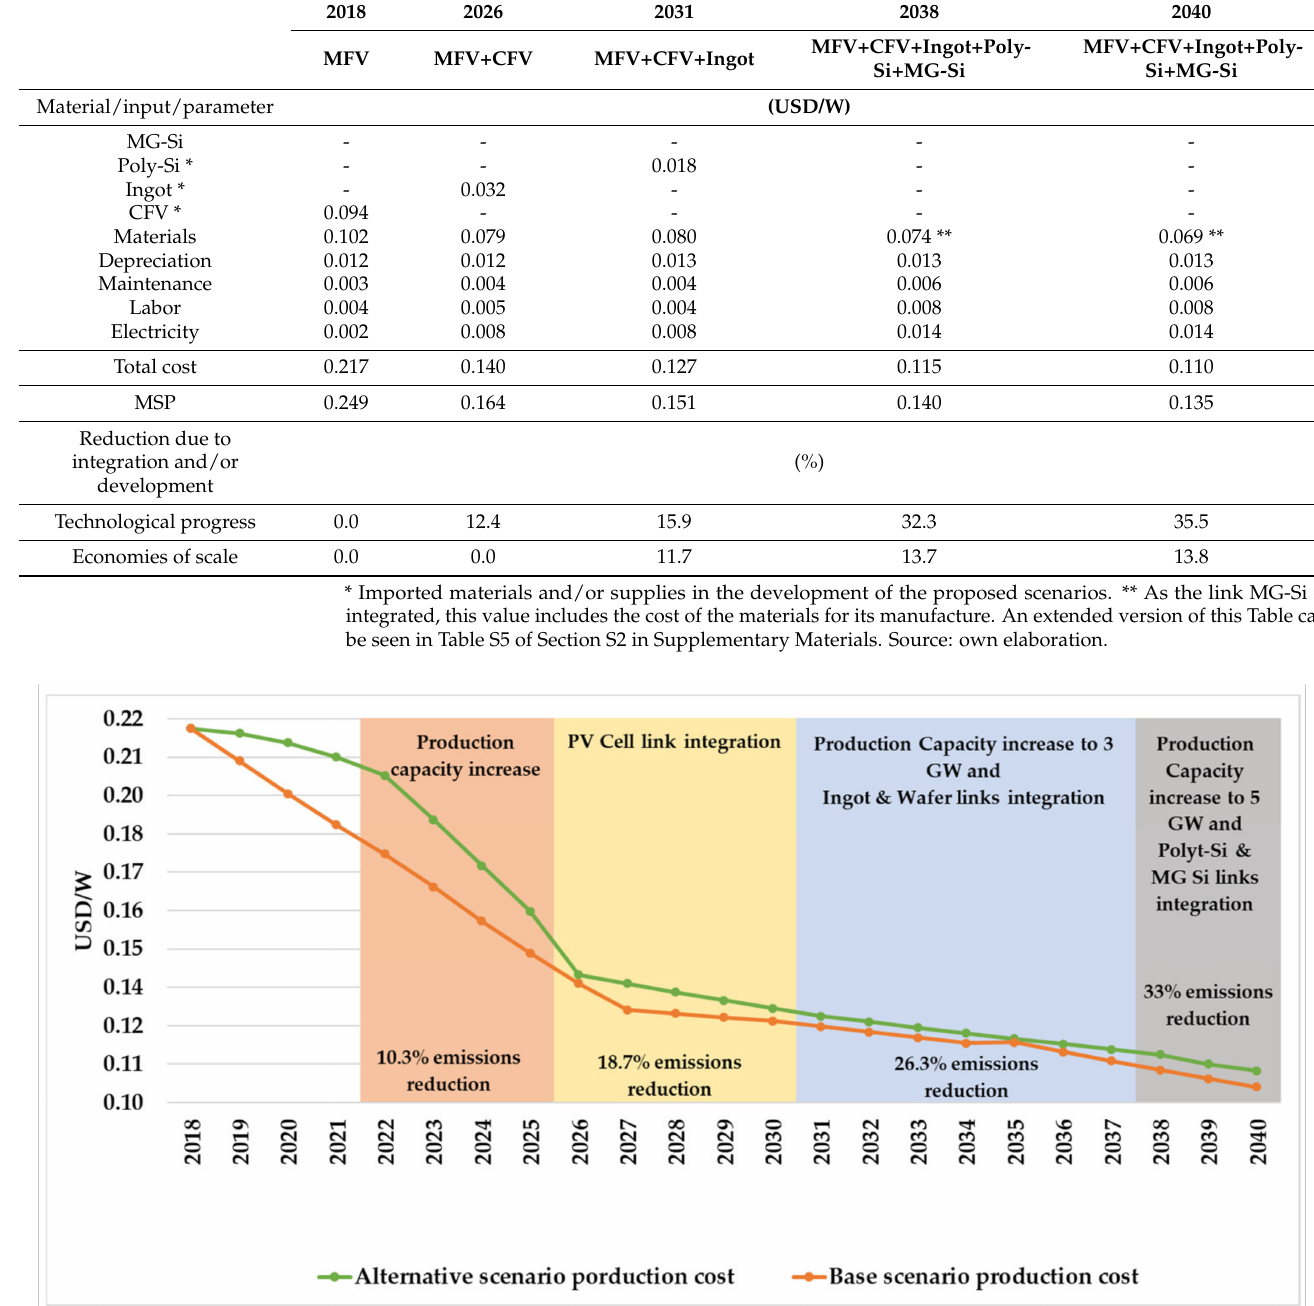
Figure 3. Evolution in the development of the Alternative Scenario and its impact on the decrease in manufacturing costs in relation to the Baseline Scenario, 2018–2040. Source: own elaboration. Likewise, Table 13 indicates the final PCN in terms of the integration of the VCPVIM links. The PCN increases by more than 80% with respect to the reference year once the VCPVIM is fully integrated towards the last year of the study period. The MFV link is the one that most contributes to the increase of the